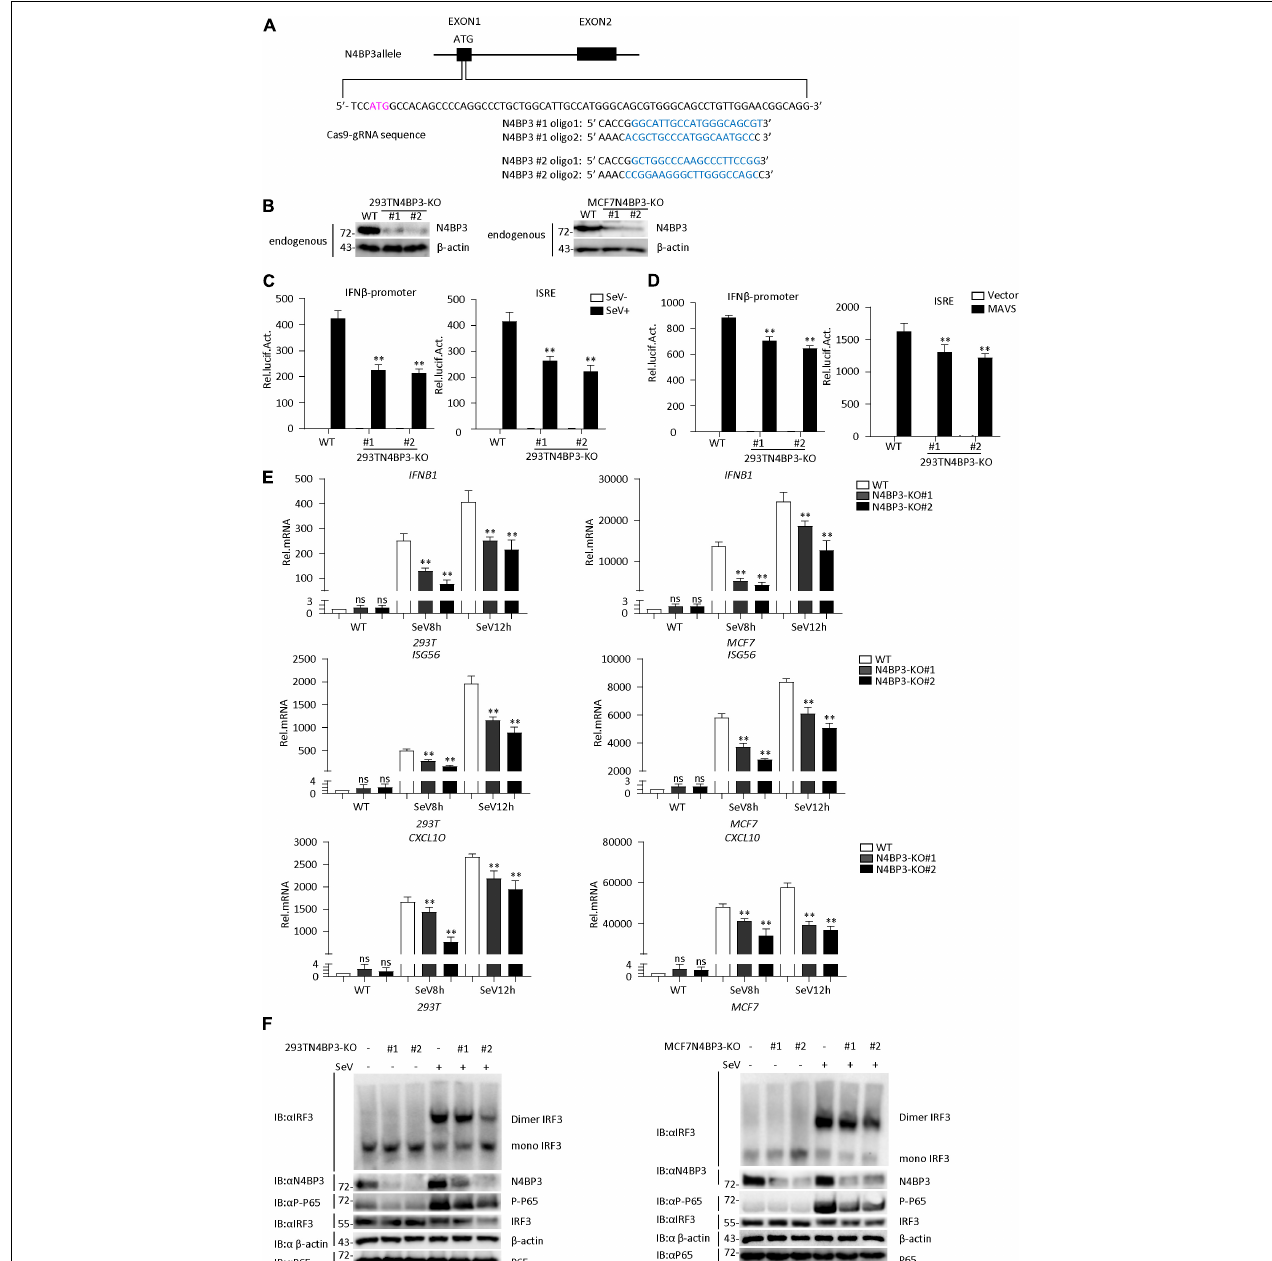
FIGURE 3 | Knockout of N4BP3 inhibits RIG-I-MAVS antiviral signaling pathway. (A) A scheme for CRISPR/Cas9-mediated genome editing of the N4BP3 gene locus. (B) Knockout efficiencies of N4BP3. Immunoblotting was used to verify the expression of N4BP3 protein in N4BP3-deficient 293T cells and MCF7 cells and control cells. (C) Knockout of N4BP3 in 293T cells can inhibit SeV-induced activation of IFN- β promoter and ISRE. 293T WT and two different N4BP3KO 293T cells were transfected with IFN- β promoter or ISRE luciferase plasmid (0.05 µ g), as well as pRL-TK (Renilla luciferase plasmid; 0.05 µ g). After 12 h of transfection, the cells were left uninfected or infected with SeV for 12 h and then subjected to luciferase detection. The data table shown were presented as mean ± SD, n = 3, ∗ P < 0.05, ∗∗ P < 0.01. (D) Knockout of N4BP3 in 293T cells can inhibit MAVS-mediated activation of IFN- β promoter and ISRE. 293T WT and two different N4BP3KO 293T cells were transfected with IFN- β promoter or ISRE luciferase plasmid (0.05 µ g) and pRL-TK (Renilla luciferase plasmid; 0.05 µ g) and empty vector or MAVS expression vector. After 20 h of transfection, then subjected to luciferase detection. The data table shown were presented as mean ± SD, n = 3, ∗ P < 0.05, ∗∗ P < 0.01. (E) Under SeV induction, knocking out N4BP3 blocked the expression of IFNB1, ISG56, and CXCL10 at the mRNA level. Control cells and N4BP3-deficient 293T cells and MCF7 cells were left uninfected or infected with SeV for 12 h and then subjected to qRT-PCR detection, while β -actin was used as an internal control. The data table shown were presented as mean ± SD, n = 3, ∗ P < 0.05, ∗∗ P < 0.01. (F) Knockout of N4BP3 inhibits SeV-induced IRF3 dimer formation and phosphorylation of P65. Control cells and N4BP3-deficient 293T cells and MCF7 cells were left uninfected or infected with SeV for 12 h. IRF3 dimers or monomers were analyzed by Native PAGE for western blot